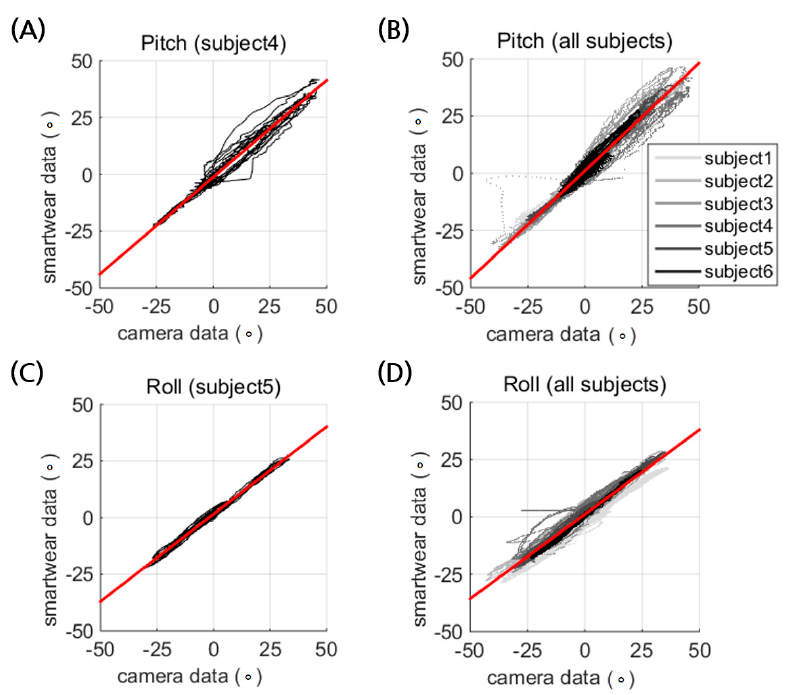
Figure 5. Calibration of the smart wear for ( A , B ), pitch and ( C , D ) roll directional tilt of the torso ranging from − 40 ◦ to 40 ◦ . The results of one representative subject ( A , C ) are followed by data from 6 subjects ( B , D ), with solid lines in different shades of gray indicating different subjects. The linear regression of each data is depicted as a red line.